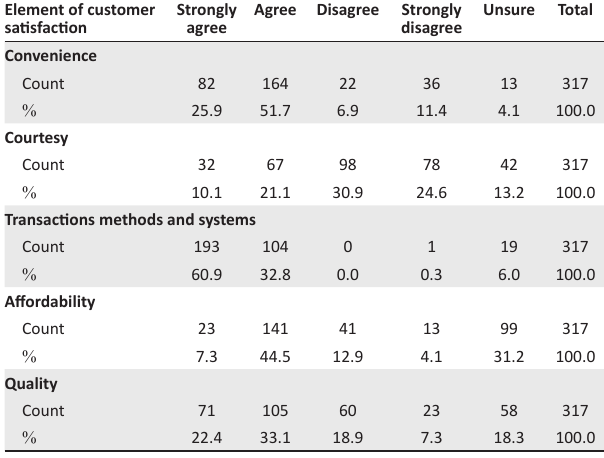
TABLE 9: Participants’ responses on customer satisfaction in the state-owned enterprises.